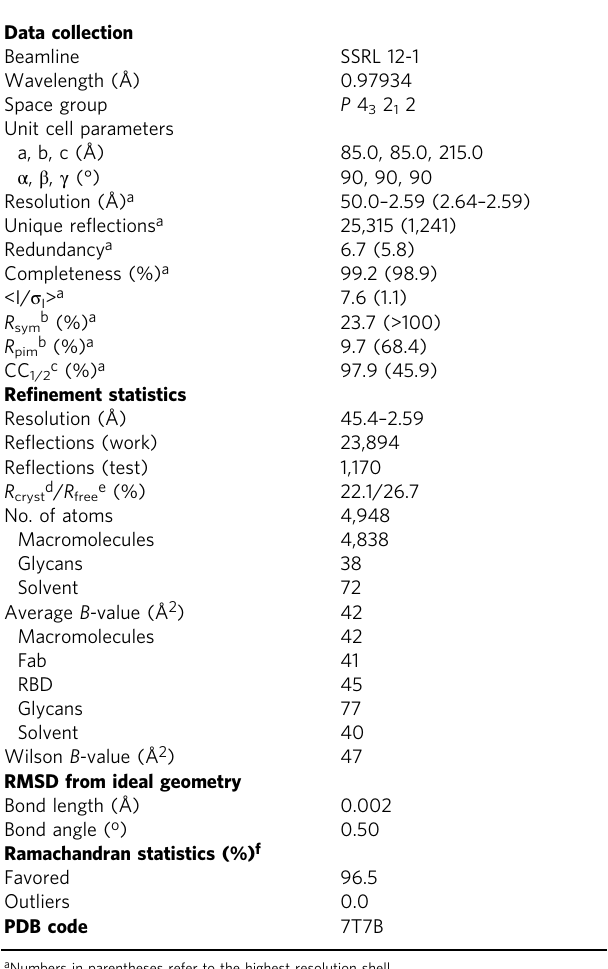
Table 1 Crystallographic data collection and re fi nement